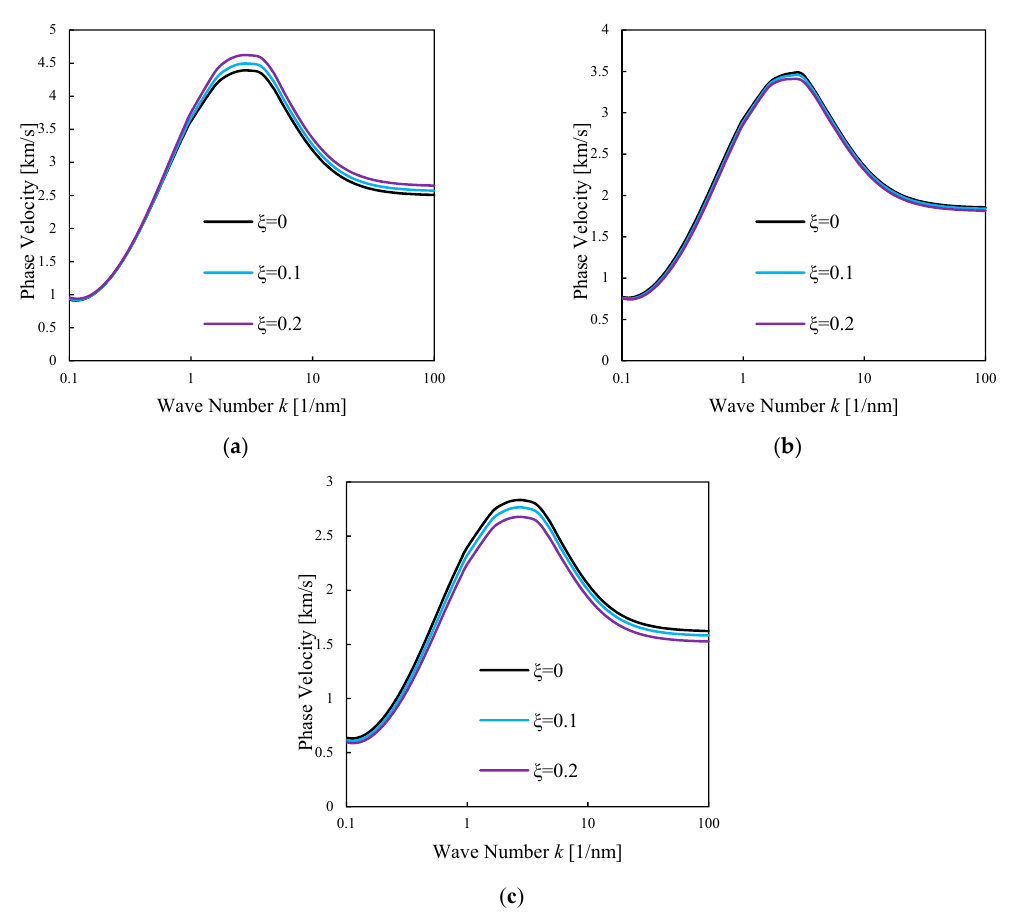
Figure 6. Phase velocity of P-FGM doubly-curved nanoshell vs. the wave number for different material compositions and porosity coefficients. R 2 = R 1 = 50 × h , λ = 0.1, µ 0 = µ 1 = 0.2; ( a ) n = 0.2, ( b ) n = 1, ( c ) n =